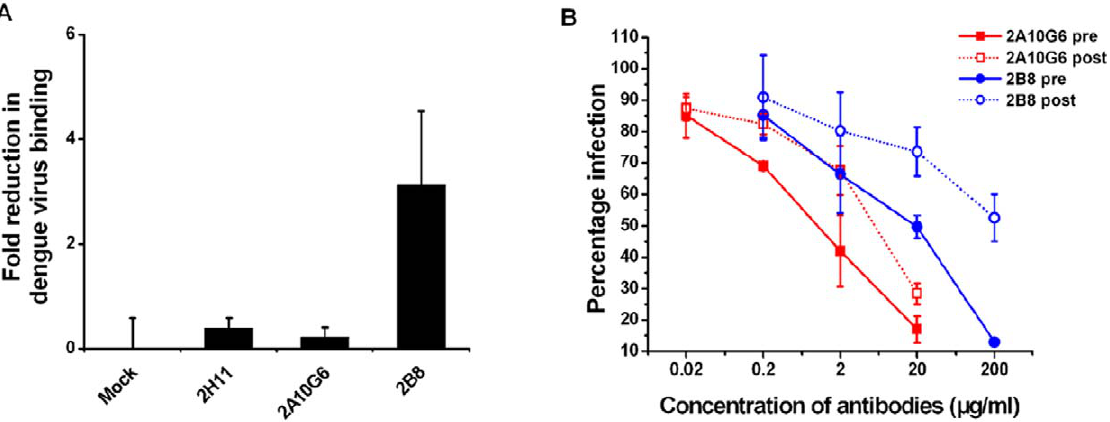
Figure 7. Mechanism of 2A10G6-mediated neutralization. A. Dengue virus binding to BHK21 cells. The DIII-specific neutralizing mAb 2B8 blocked cellular attachment significantly more than the DI–DII–specific neutralizing mAb 2A10G6 or controls, including no antibody (BSA) and the non-neutralizing mAb 2H11. Fold reductions are reported with standard deviations as the average of four independent experiments. B. Pre- and post- adsorption inhibition assays. Pre-binding of DENV2 with 2A10G6 or 2B8 significantly protected against infection (solid lines) (Pre). In contrast, 2A10G6 but not 2B8 inhibited infection when added after virus binding (dotted lines) (Post). Infection percentages at the different antibody concentrations are shown with standard